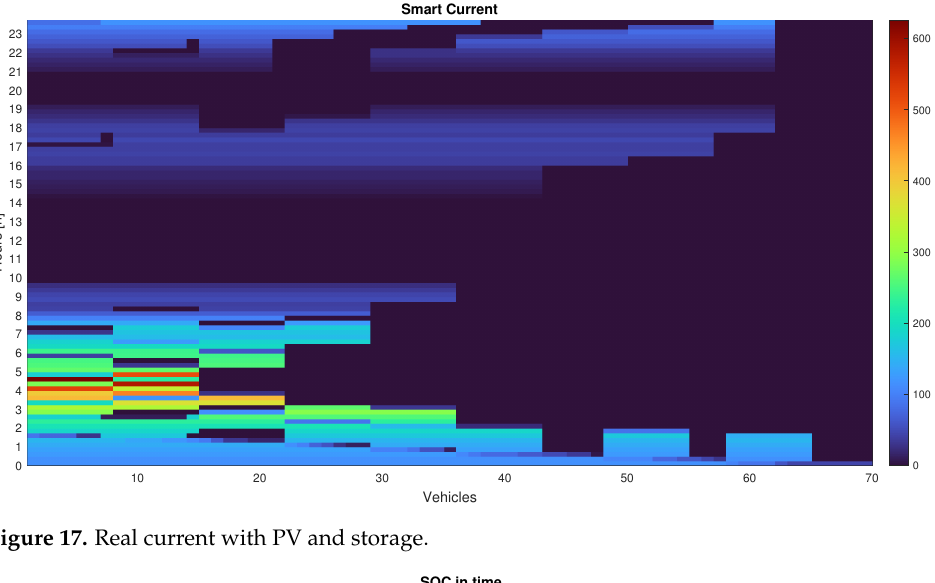
Figure 17. Real current with PV and storage.